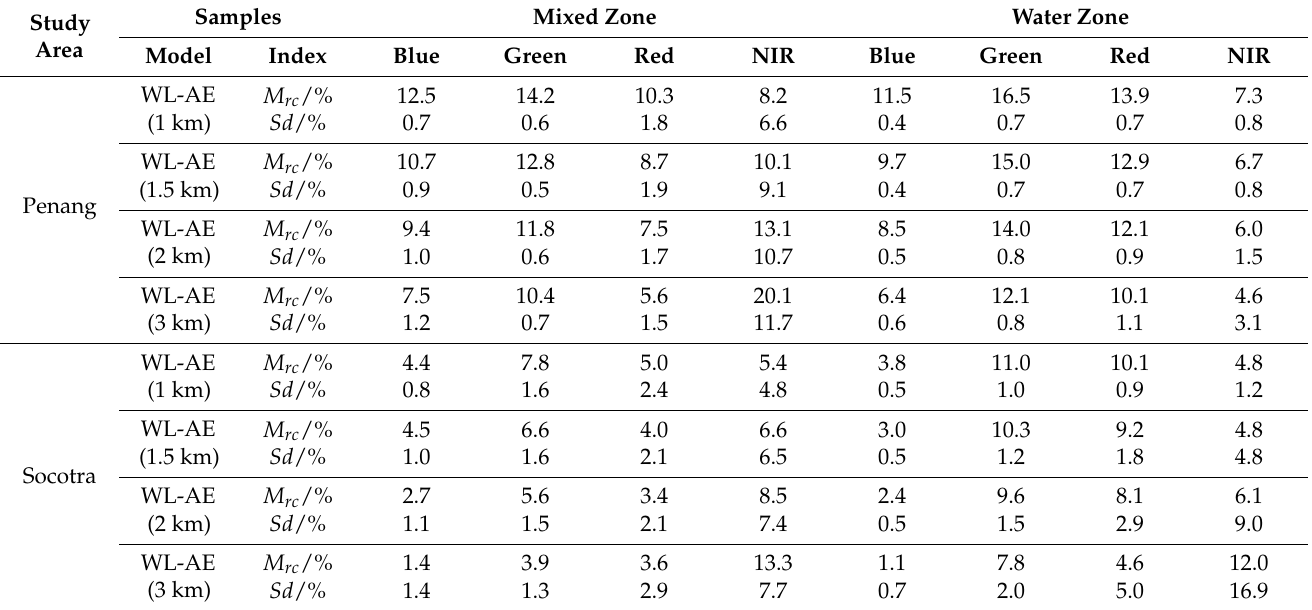
Table 3. Analysis indices of the CTS Correction Results Obtained Under Different R ns